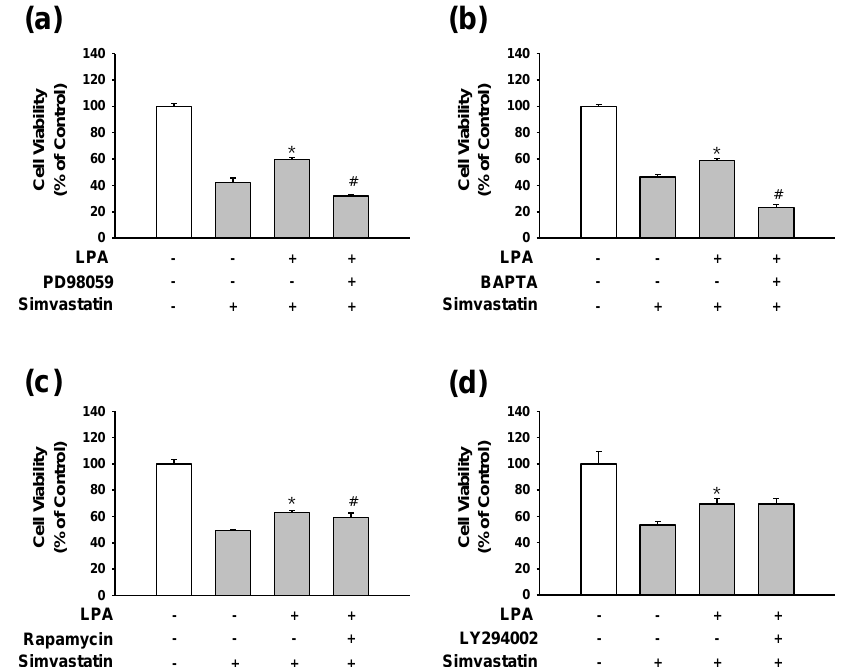
Figure 5. Effects of MAP kinase, intracellular calcium, PI3K, or mTOR inhibition on the viability of LPA-treated L6 cells in the presence of simvastatin. Cells were treated with or without ERK1/2 inhibitor PD98059 (10 μM) ( a ), intracellular calcium chelator BAPTA- AM (5 μM) ( b ), PI3K inhibitor LY294002 (25 μM) ( c ), or mTOR inhibitor rapamycin (2 μM) ( d ) in the presence of LPA (10 μM) or simvastatin (10 μM) in serum free medium. After 48 h incubation, XTT assay was performed. Data represent the means ± SEM (n = 6 for each experiment). * p < 0.05 vs. simvastatin alone; # p < 0.05 vs. LPA with simvastatin.